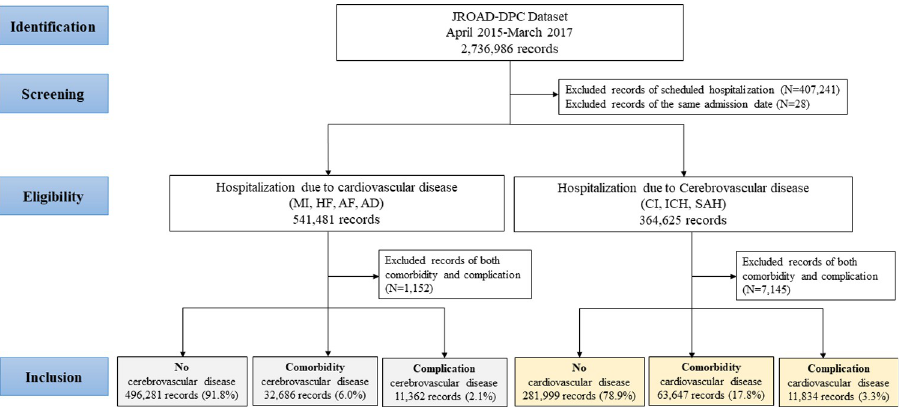
Fig 1. Study flow charts for comorbidities and complications of cardiovascular and cerebrovascular diseases in JROAD-DPC. AD, aortic dissection; AF, atrial fibrillation; CI, cerebral infarction; HF, heart failure; ICH, intracerebral hemorrhage; JROAD-DPC, Japanese Registry Of All cardiac and vascular Disease-Diagnostic Procedure Combination; MI, myocardial infarction; SAH, subarachnoid